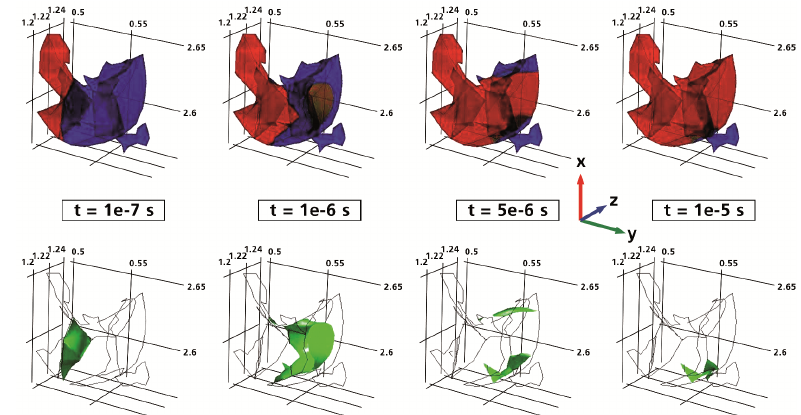
Figure 9. Image series showing the propagation of supercritical CO 2 displacing H 2 O (above) as well as the corresponding propagation of the fluid–fluid interface (below) at p c = 15 e 6Pa. The series is given for selected time steps within the µ -CT-based single pore geometry. Blue, red and green colours represent H 2 O, CO 2 phase and the fluid–fluid interface respectively. Grid values are given in millimetres.